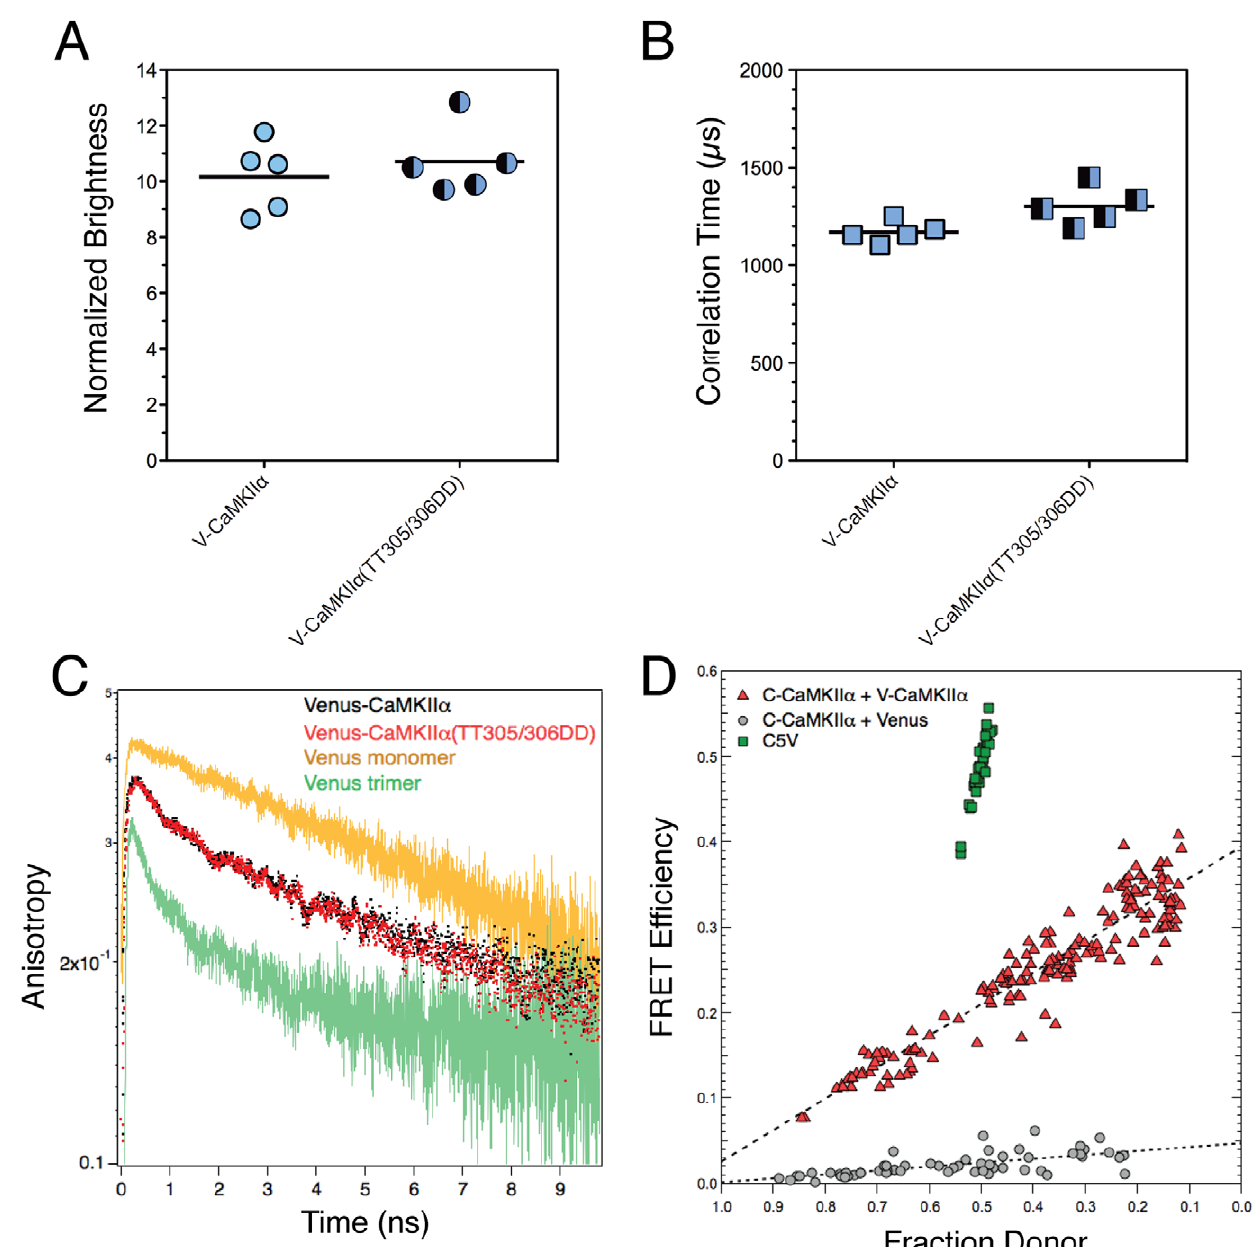
Figure 3. FPFA of CaMKII a holoenzyme. (A) The normalized brightness for V-CaMKII a holoenzyme, and mutant that cannot bind Ca 2 + /CaM. Bars representthemeanswith n=5.Theexcitationpowerusedwas10.2 mW.(B)ThecorrelationtimesforsamplesinpanelA.(C)AverageTRAforsamplesin panel A. TRA traces for Venus monomers (V1) and Venus trimers (V3) from figure 2B are overlaid as a reference, and to illustrate that the Venus-tagged catalytic domains in V-CaMKII a produce an anisotropy signal most consistent with Venus-dimers. (D) Hetero-FRET analysis of CaMKII a catalytic domain pairing in living cells. Cells were transfected with DNA constructs encoding CaMKII a tagged on the catalytic domain with either Cerulean or Venus. Cells transfectedwith Cerulean-CaMKII a &freeVenusmonomerswereusedasa negativeFRETcontrol.CellstransfectedwithC5Vwasusedasa positiveFRET control. Each point is the average FRET efficiency and fraction donor value measured for an individualcell. Dashed lines are linear fits.